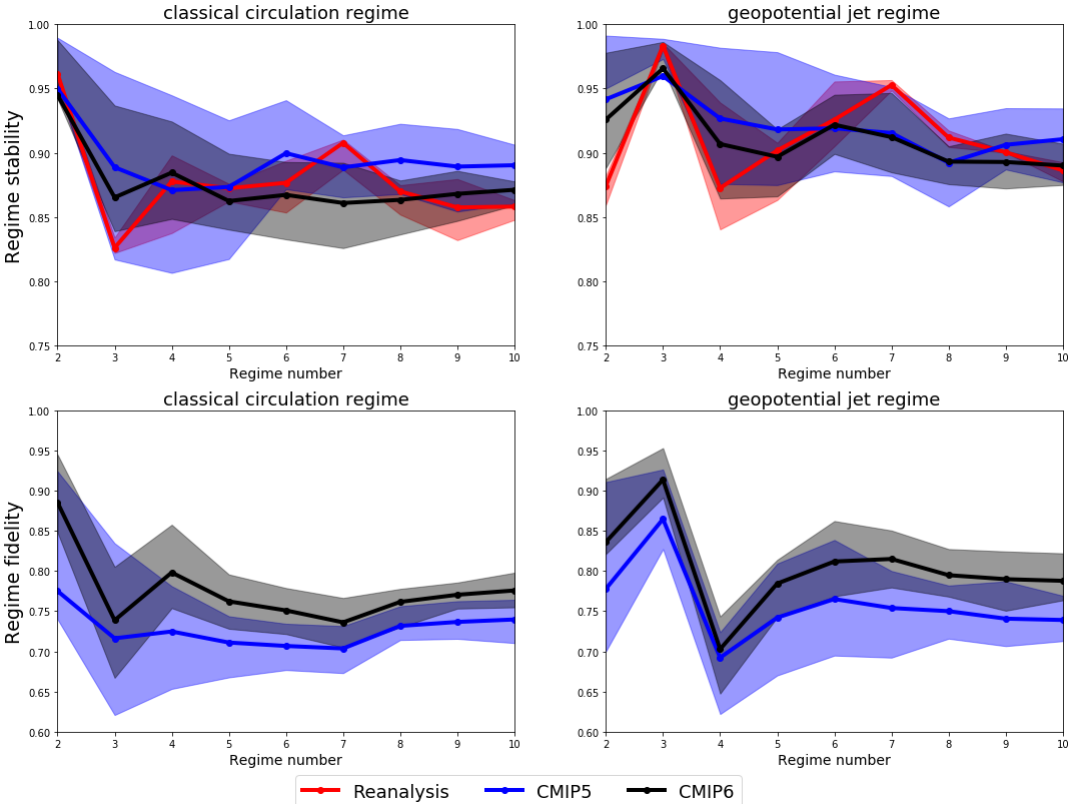
Figure 5. Regime stability and fidelity, calculated with 30-year subsamples, as a function of regime number for both the classical circulation and geopotential-jet regime frameworks. Lines show the mean value for each dataset, while shading shows the ensemble interquartile